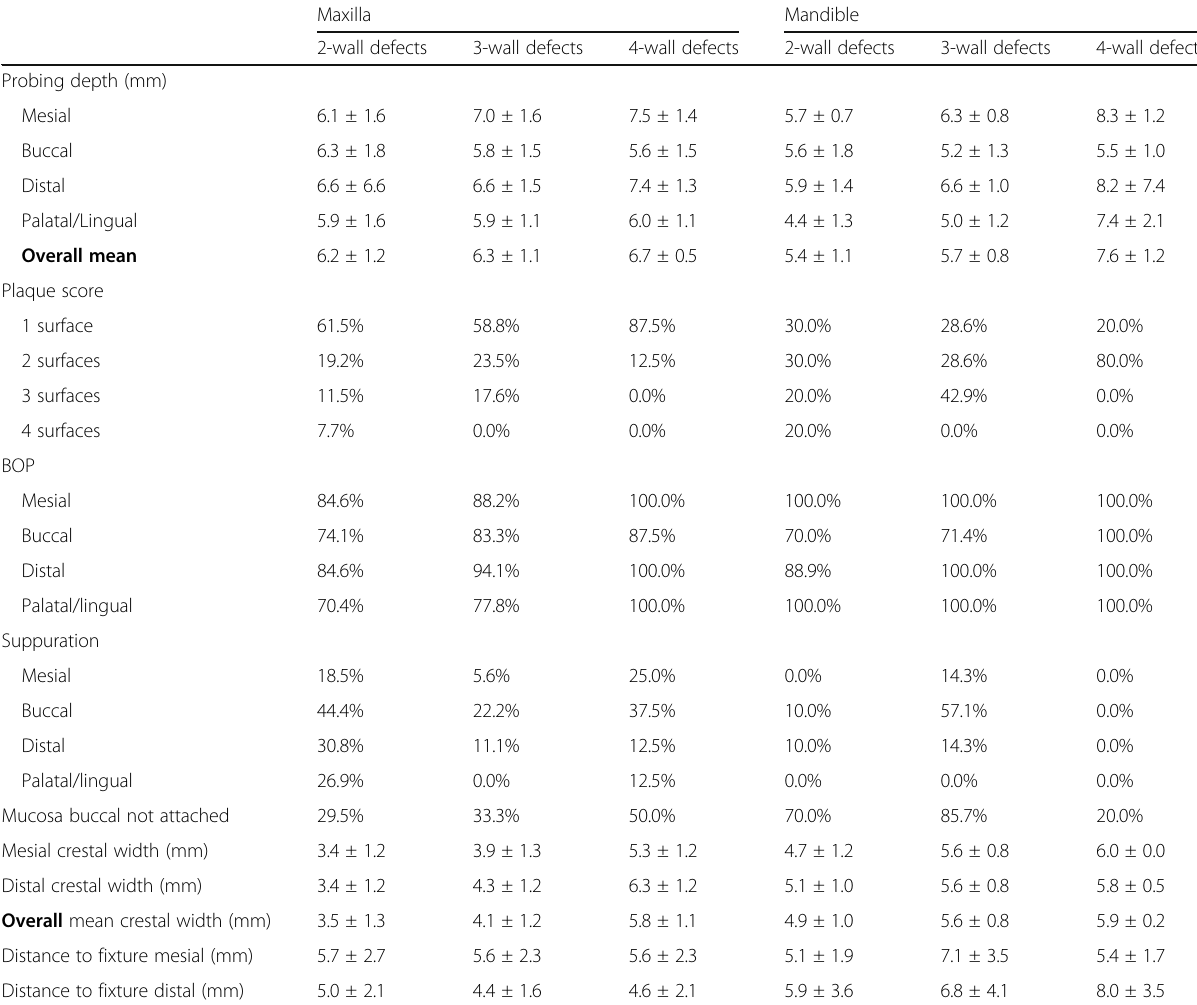
Table 2 Distribution of clinical measurements before and during surgical procedures (mean values and standard deviation) for defects at implants in the maxilla or